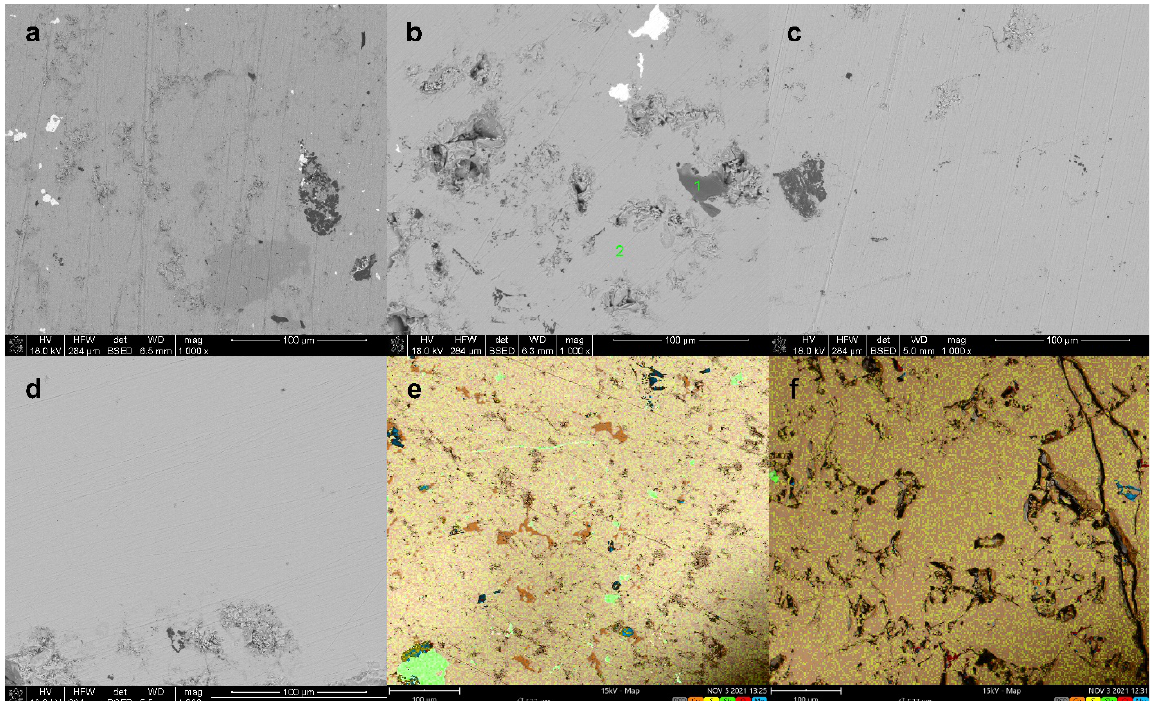
Figure 11. Scanning electron micrographs of Mg x Cu 12 Sb 4 S 13 sintered samples. ( a ) Mg 0 . 5 Cu 12 Sb 4 S 13 ; ( b ) Mg 1 . 0 Cu 12 Sb 4 S 13 ; ( c ) Mg 1 . 5 Cu 12 Sb 4 S 13 ; ( d ) Mg 2 . 0 Cu 12 Sb 4 S 13 ; ( e , f ) Mg 0 . 5 Cu 12 Sb 4 S 13 , Mg 1 . 0 Cu 12 Sb 4 S 13 back-scattered electrons SEM image combined with EDS analysis. Table 2. Stoichiometric coefficients of Mg x Cu y Sb z S 13 tetrahedrite calculated from results of EDS point analysis. Mg d